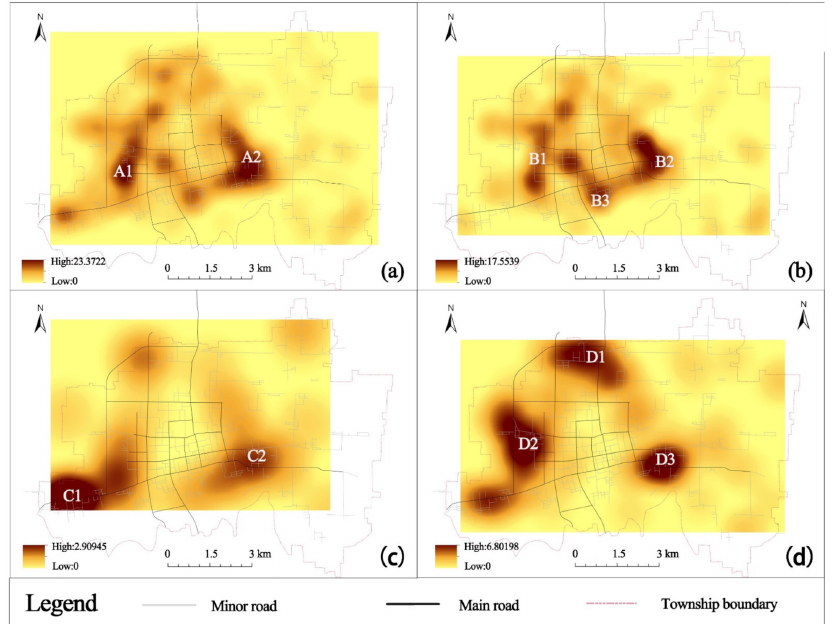
Figure 6. Distribution of nuclear density of urban inefficient land use sites in the central urban area of Dali. (( a ). Inefficient land; ( b ). Inefficient residential land; ( c ). Inefficient industrial land; ( d ). Inefficient commercial land).